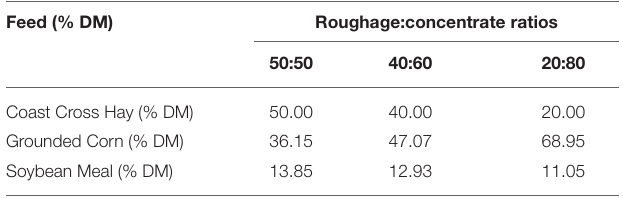
TABLE 1 | Centesimal composition of diets with different roughage : concentrate ratios. Feed (% DM) Roughage:concentrate ratios